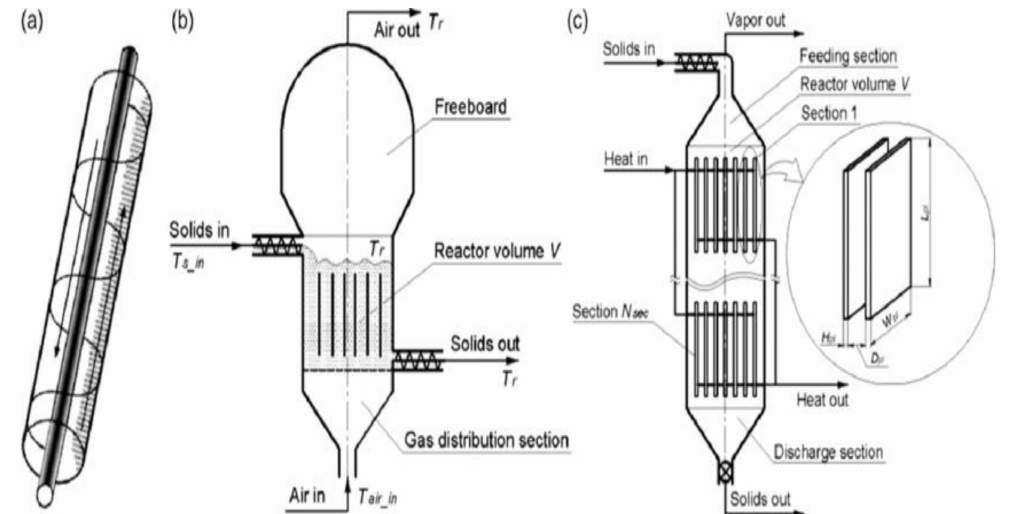
Figure 17. Types of reactors: ( a ) Screw reactor; ( b ) Fluidized bed reactor [131]; ( c ) Gravity-assisted bulk flow reactor